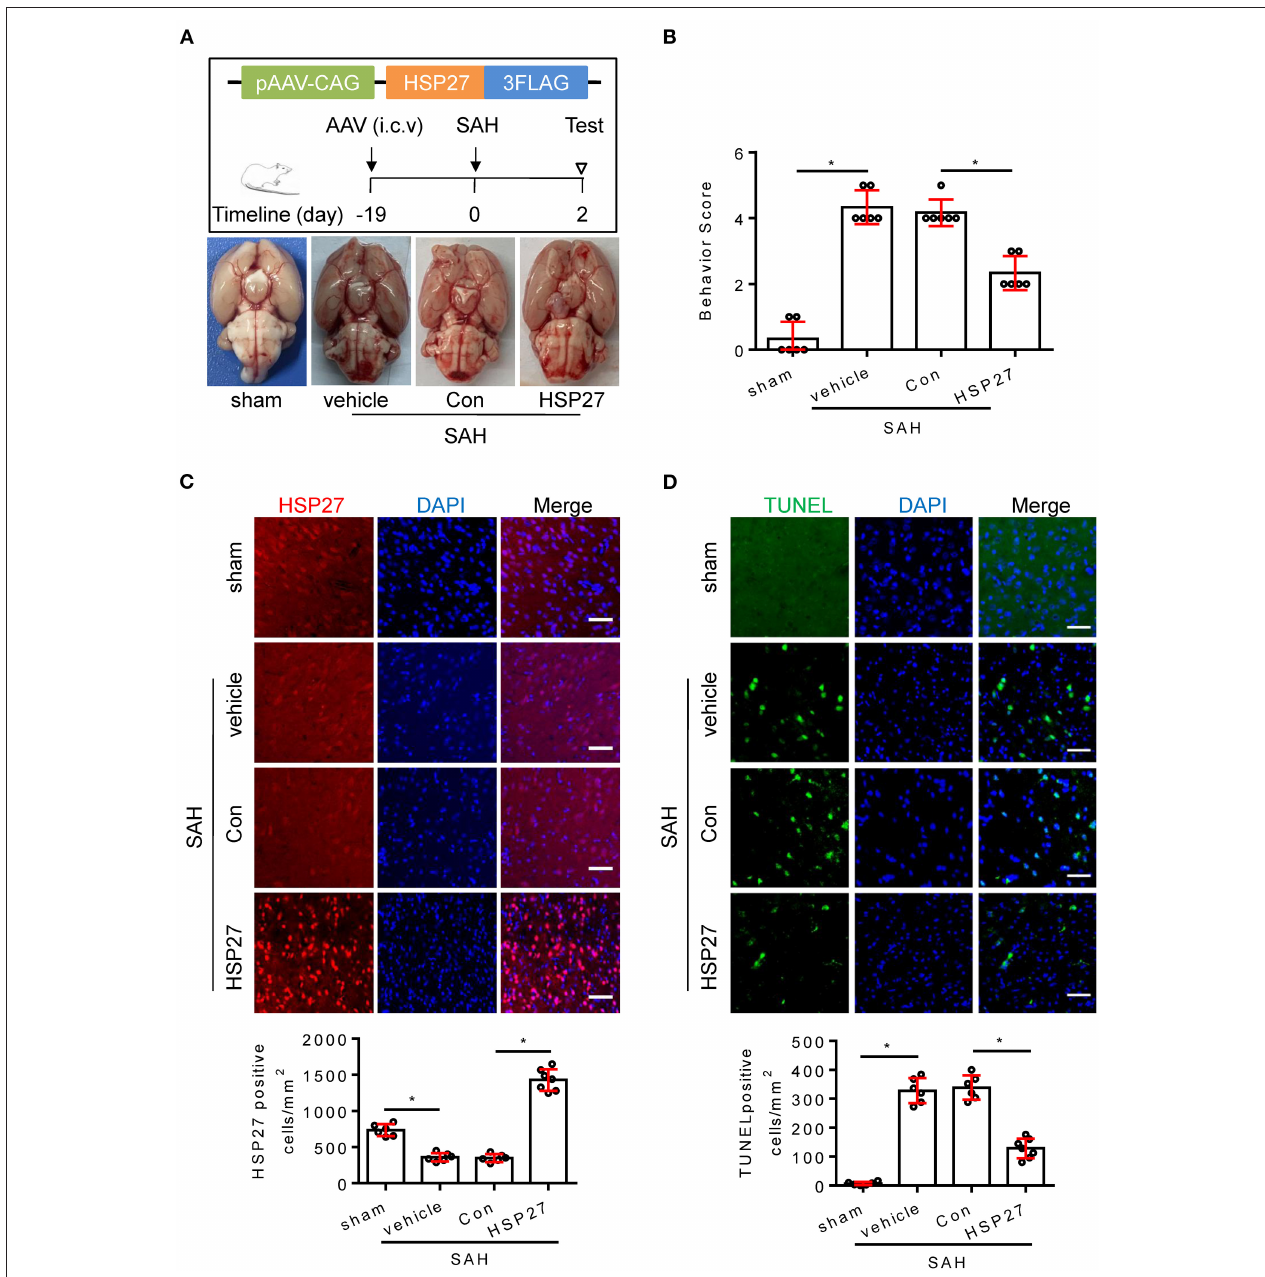
FIGURE 5 | HSP27 overexpression attenuated neurological deficit and cell apoptosis after SAH in rats. (A) Schematic of AAV vector encoding HSP27 and experimental design. Representative images of rat brain on day 2 after surgery for the sham, SAH + vehicle, SAH + AAV vector (SAH + Con), and SAH + AAV vector encoding HSP27 (SAH + HSP27) group. (B) Behavior scores of each group were assessed at 48h, n = 6. (C,D) Coronal sections from the sham ( n = 6), SAH + vehicle ( n = 6), SAH + Con ( n = 6), and SAH + HSP27 ( n = 7) group reperfusion on day 2 after SAH, subjected to immunostaining for the HSP27 (red) or TUNEL (green) in the basal cortex. Quantification was performed by counting the HSP27 or TUNEL positive cells per mm 2 region in the basal cortex, scale bar = 50 µ m. Data are mean ± SD, * p < 0.05, ANOVA with Bonferroni’s multiple comparisons test.